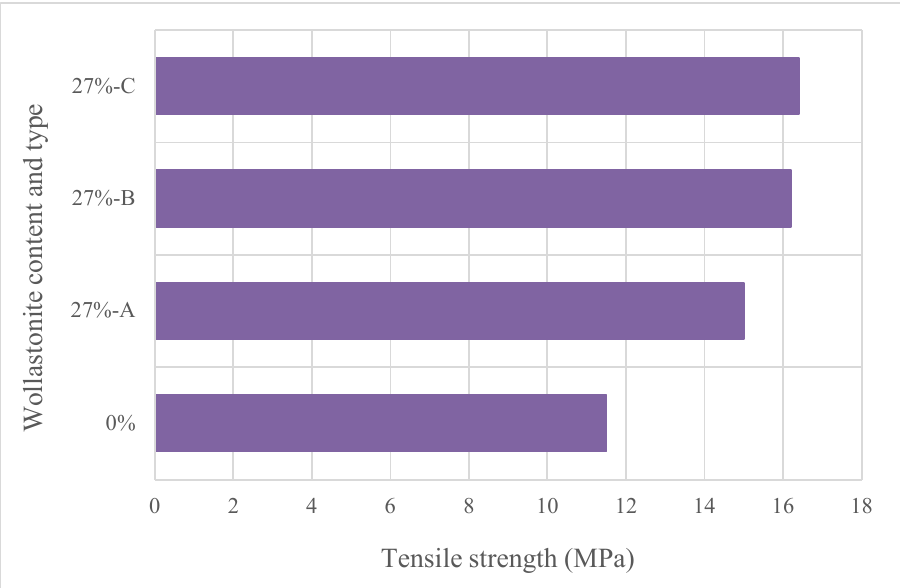
Figure 13. Tensile strength of 27% substitution of different types of wollastonite based on Ref. [57].